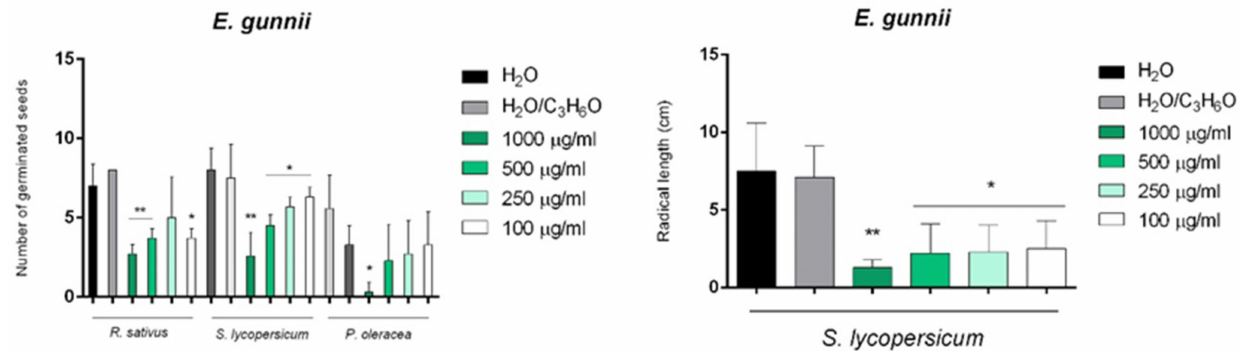
Figure 7. Phytotoxic activity of E. gunnii (EG) EO against the germination of P. oleracea , R. sativus , and S. lycopersicum and the radical elongation of S. lycopersicum 120 h after sowing. The results are the mean of three experiments ± standard deviation. * p < 0.05 and ** p < 0.01 compared with control (ANOVA followed by Dunnett’s multiple comparison test).